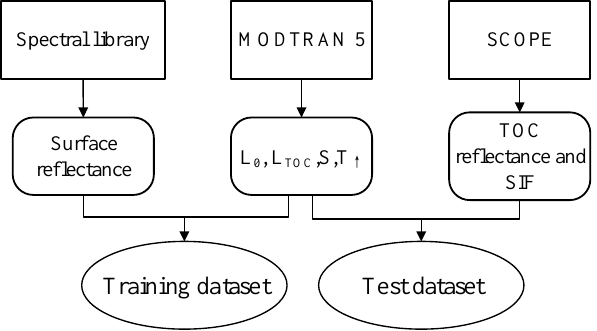
Figure 5. Flow-chart of the process used to produce the simulated dataset.